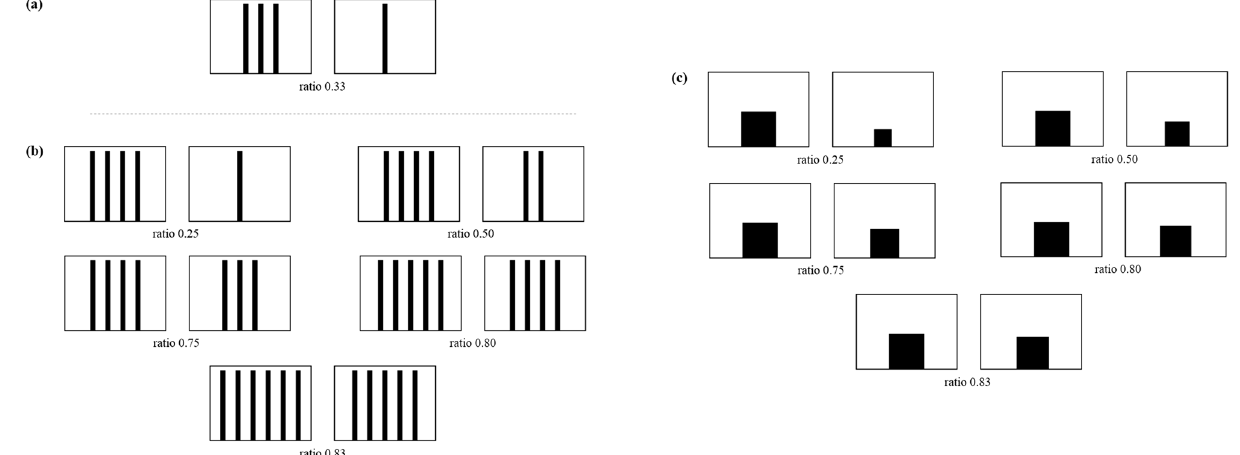
Figure 2. ( a – c ) Stimuli used in Experiment 1a, 1b and 1c,